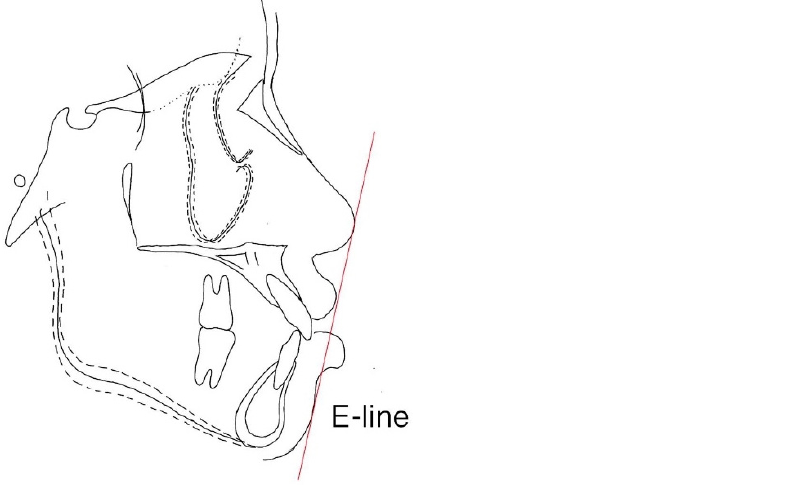
Figure 7. Ricketts’ Esthetic line (E-line). The line is drawn from the tip of the nose to the soft-tissue pogonion.